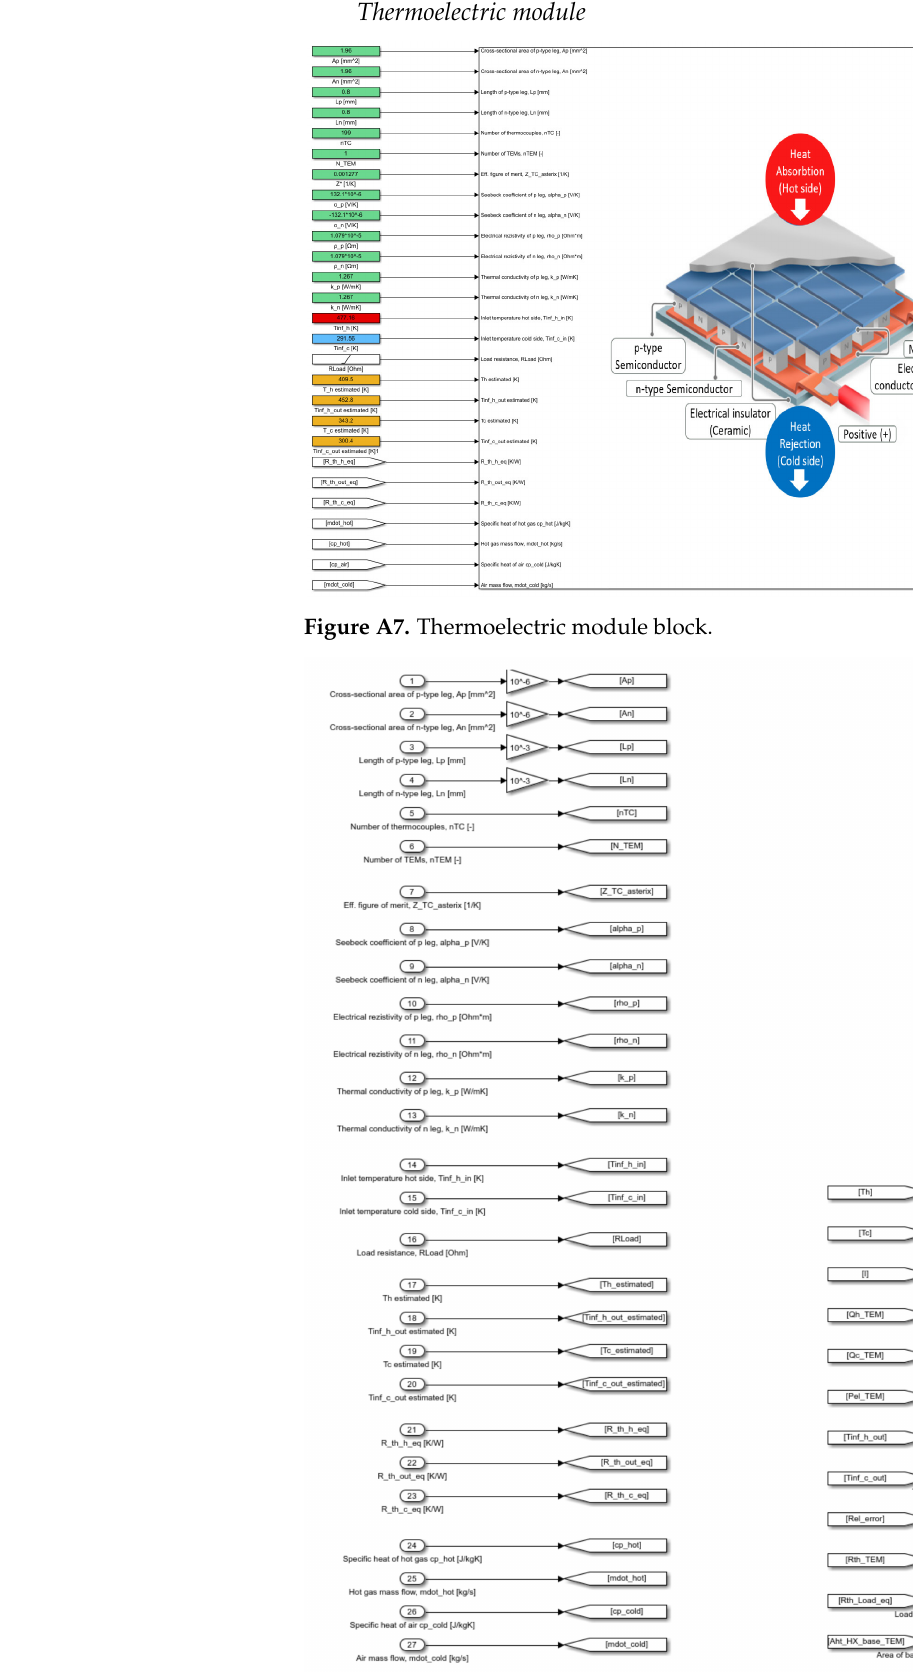
Figure A8. Thermoelectric module block—inputs and